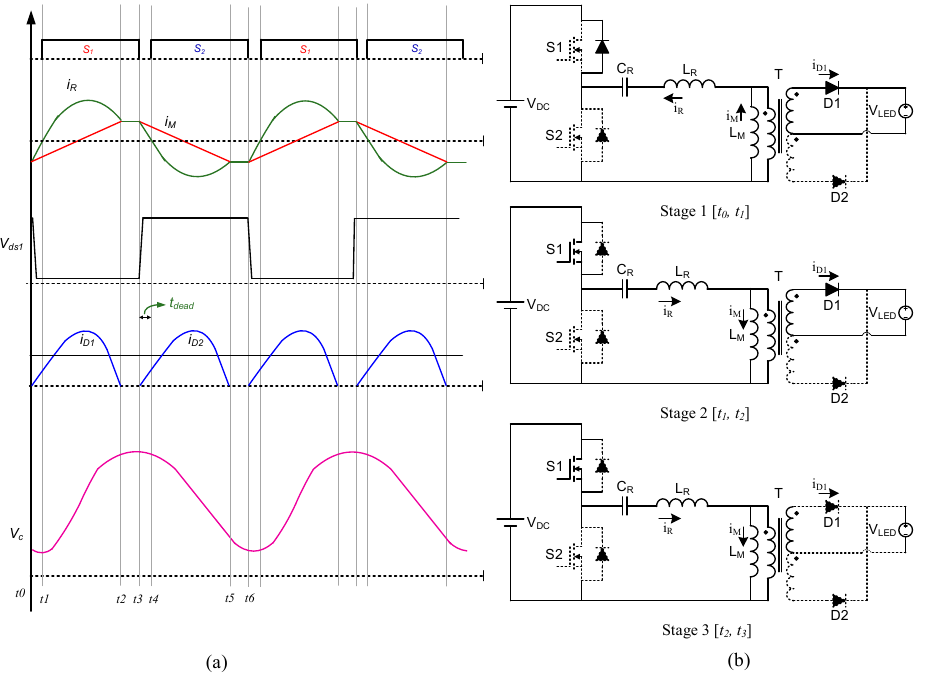
Figure 7. ( a ) Operating waveforms and ( b ) equivalent circuit.